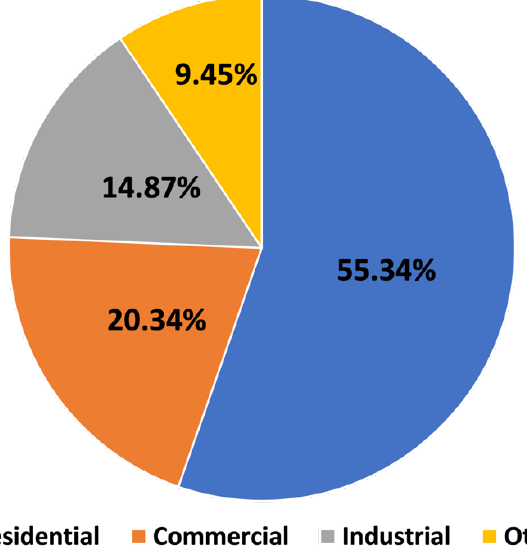
Figure 1. Shares of Energy Sales.